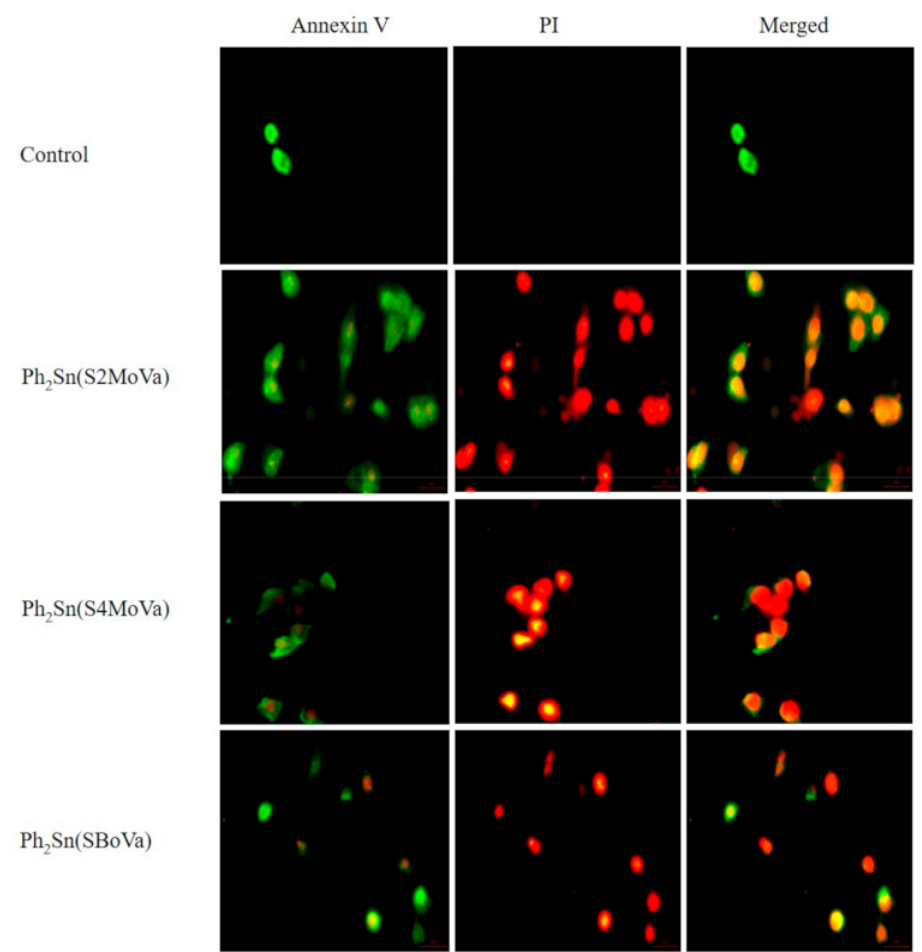
Figure 6. Apoptosis detection through fluorescence microscopy. Cells were treated for 24 h with Ph 2 Sn(SBoVa) (0.58 µ M), Ph 2 Sn(S2MoVa) (0.31 µ M) and Ph 2 Sn(S4MoVa) (1.66 µ M) and the negative control (DMSO) in complete media. After staining with Annexin V and PI, necrotic and apoptotic cells were detected by fluorescence microscopy (20 ×